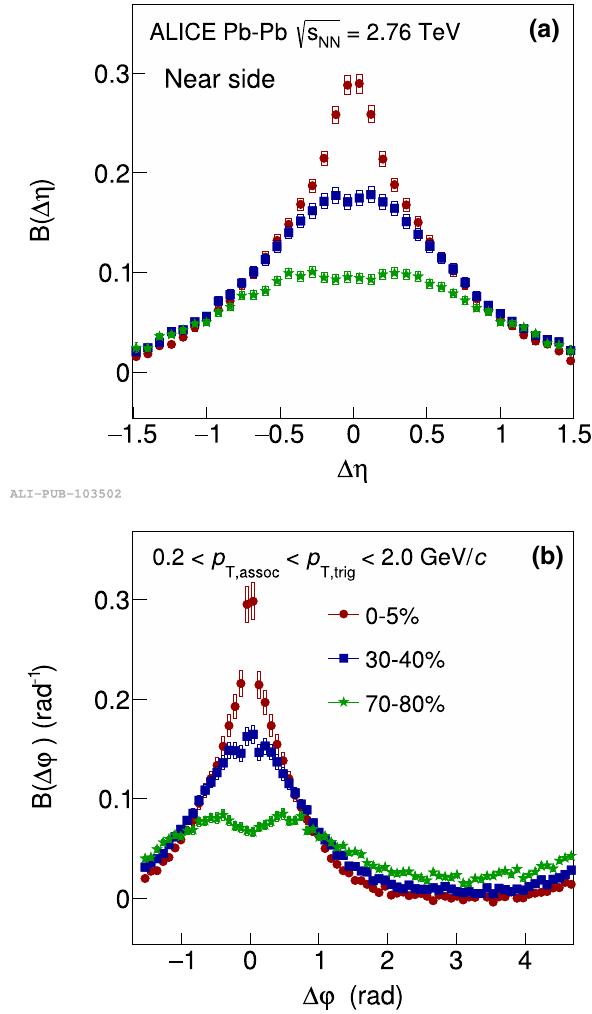
√ Fig. 2 Top: the balance functions in s NN = 2 . 76TeV Pb–Pb col- lisions as a function of the pseudorapidity separation between two charged particles on the near side (for relative azimuthal separations − π/ 2 < (cid:4)ϕ < π/ 2). One observes a clear narrowing in central col- lisions. Taken from Ref. [31]. Bottom: similar to the top plot but for separation in azimuthal